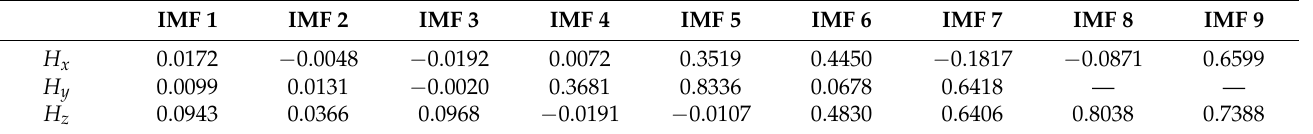
Figure 8. The flow chart of EMD-Wavelet threshold denoising.